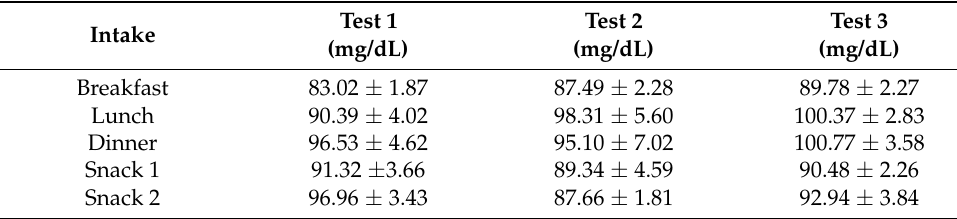
Table 5. Postprandial glucose average at each